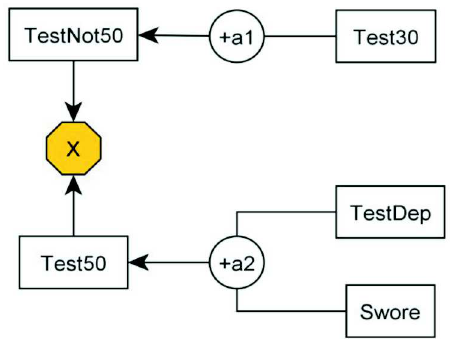
Figure 1. Conflict Diagram of the Speeding